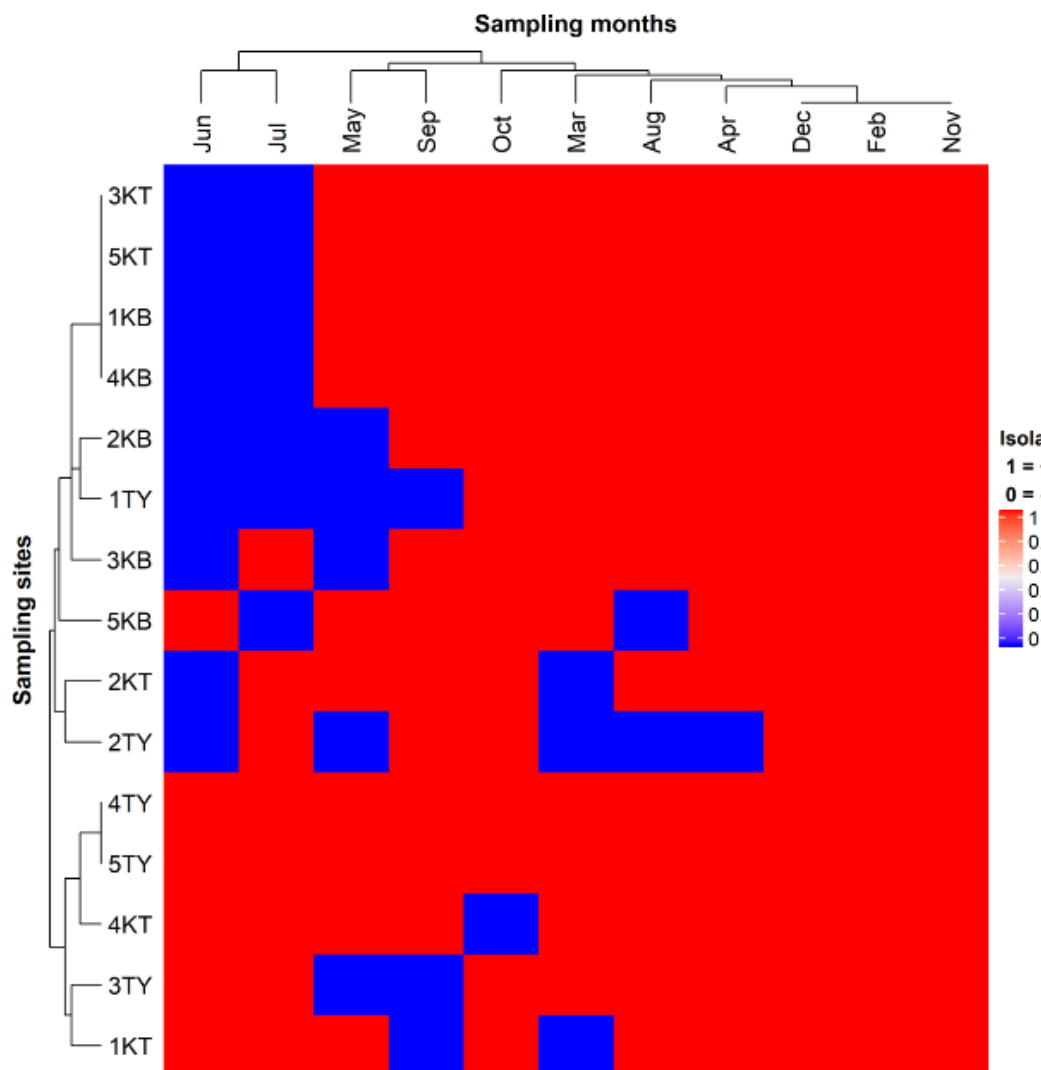
Figure 1. Heatmap of cultural detection of P. shigelloides across months in water samples collected from selected rivers in the Eastern Province. Red color represents positive isolation of P. shigelloides, while blue color represents no isolation. 1KB, Stutt. Game Reserve*; 1KT, Seymour; 1TY, Hogsberg; 2KB, StuttTW1*; 2KT, Katberg; 2TY, Hillfoot*; 3KB, StuttVBridge1*; 3KT, Balfour; 3TY, Kayalethu; 4KB, StuttEbBridge*; 4KT, Blinkwater; 4TY, Binfield; 5KB, StuttFbridge*; 5KT, Fort Beaufort; 5TY, Melani. * Arbitrary name.